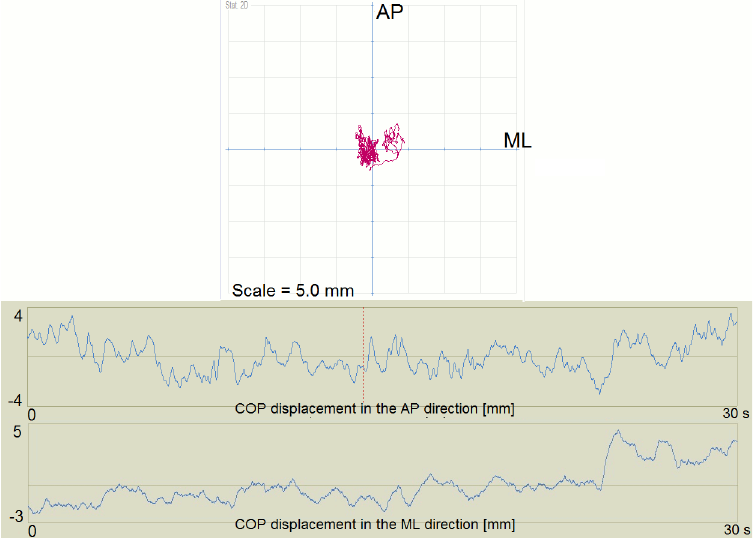
Fig 2. Example of the short path length for the COP. COP, Center of Foot Pressure; AP, anteroposterior direction; ML–mediolateral direction.